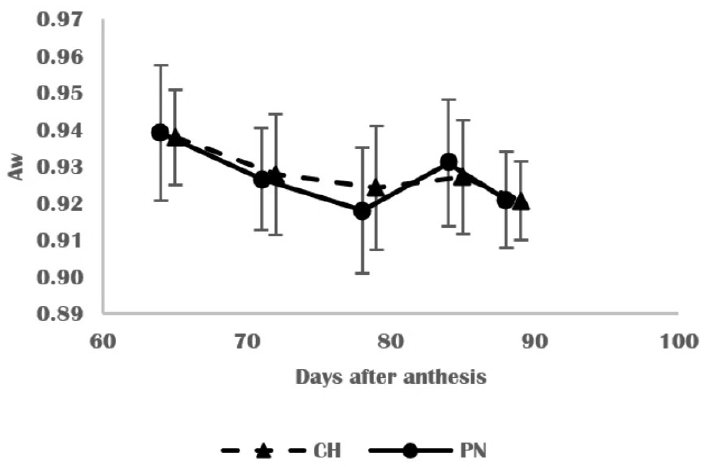
Figure 3. Water activity (Aw) from Pinot noir ( • ) and Chardonnay ( (cid:78) ) grapes. Means of 10 replications ±